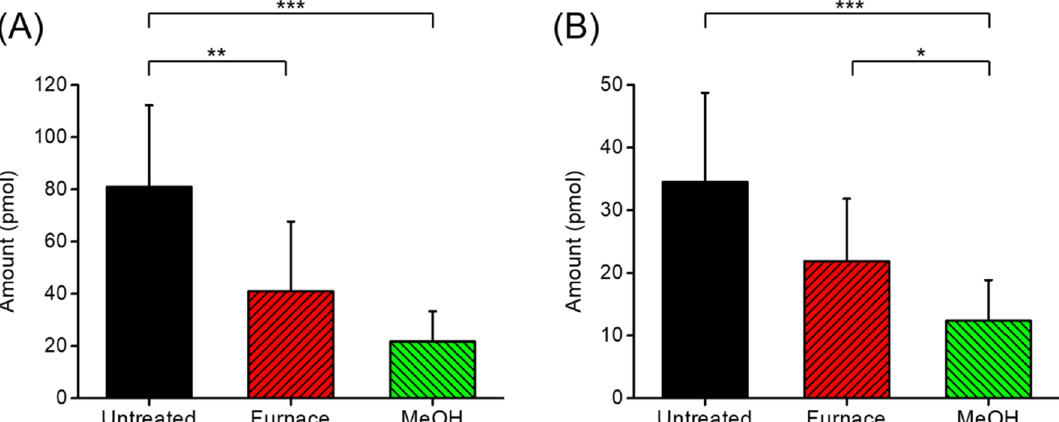
Figure 1. A comparison of the amount of exogenous ( A ) PA and ( B ) SA extracted from GLASSCO glass tubes with different pretreatment methods (furnace baking and MeOH washing). Data are shown as the mean ± standard deviation ( n = 18). Asterisks denote statistically significant differences by Dunn’s post hoc test (* P < 0.05, ** P < 0.01 and *** P < 0.001,